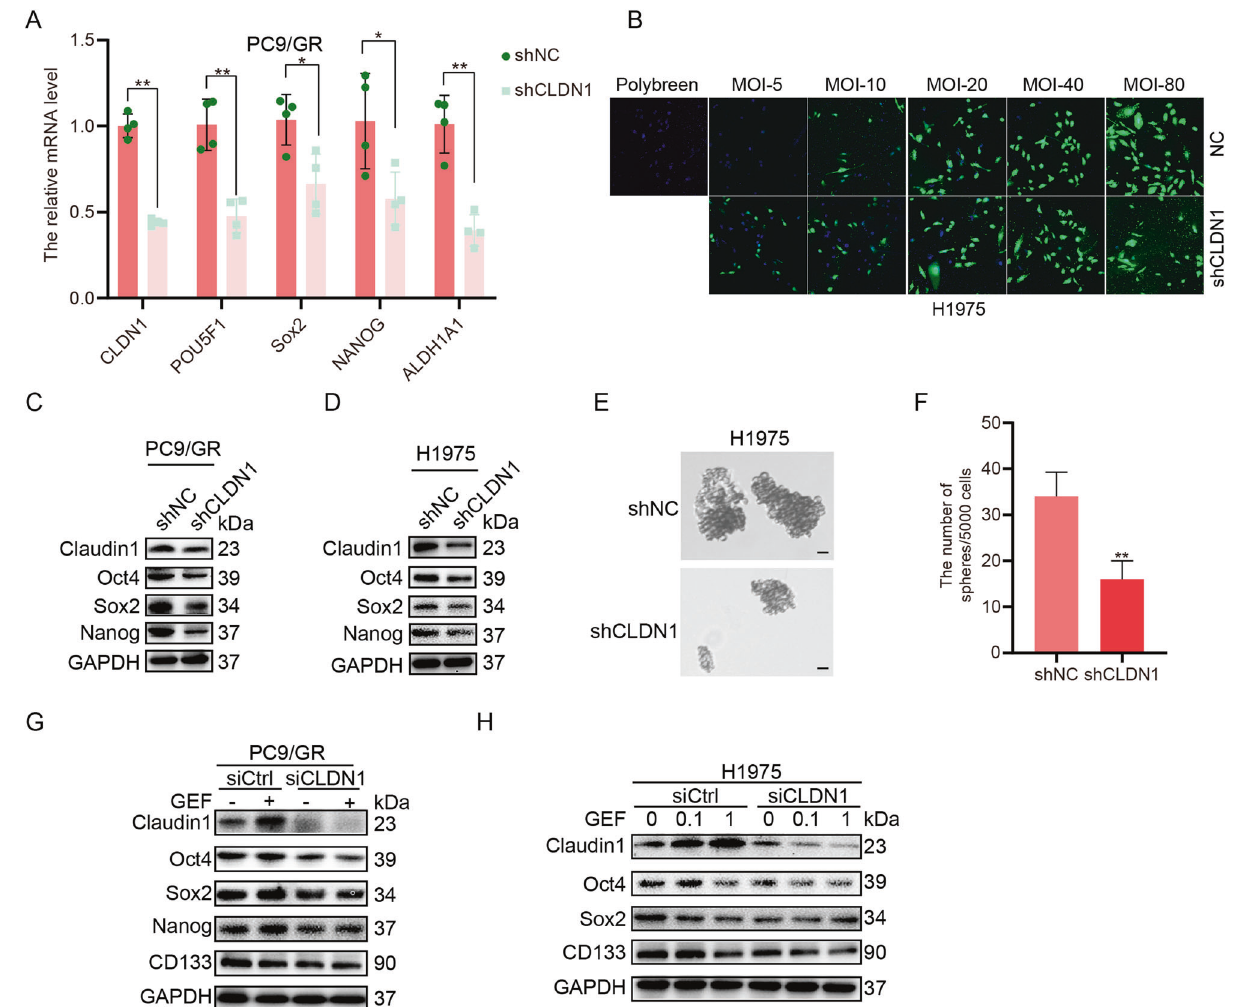
Fig. 4 Claudin1 knockdown inhibits cancer cell stemness in NSCLC cells. A PC9/GR cells were infected with a lentivirus for 48 h. Then, total RNA were extracted and mRNA expression levels of CLDN1 , POU5F1 , Sox2 , NANOG , and ALDH1A1 were detected by real-time PCR (mean ± SD; n = 6; * P < 0.05, ** P < 0.01). B H1975 cells were infected with a lentivirus for 72 h and infection ef fi ciency was detected by a laser scanning confocal microscope. Note: Numbers represent MOI values; lentivirus concentration: 3.0 × 10 8 TU/mL. C , D PC9/GR and H1975 cells were infected with lentivirus for 48 h and the expression of claudin1, Nanog, Sox2, and Oct4 was evaluated by western blotting. E , F Sphere formation of H1975 cells was observed after claudin1 knockdown. Cell spheres that were characterized by tight, spherical, non-adherent colonies of >90 μ m in diameter were counted (Scale bar: 100 μ m; original magni fi cation: ×100; representative images from three experiments; mean ± SD; ** P < 0.01). G siRNA was transfected for 6 h, then PC9/GR cells were treated with ge fi tinib (1 μ M) for another 48 h, the protein was extracted and expression levels of claudin1, Oct4, Sox2, Nanog, and CD133 were evaluated by western blotting. H H1975 cells were transfected with siCLDN1 or siCtrl for 6 h, and then treated with ge fi tinib (1 μ M) for another 48 h, and the expression levels of claudin1, Oct4, Sox2, and CD133 were